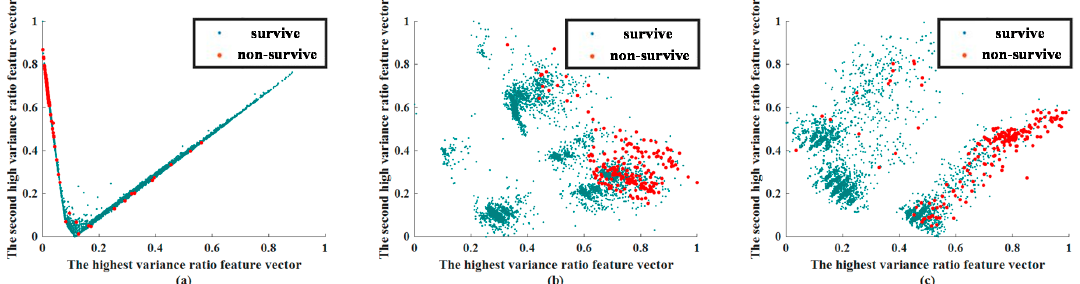
Figure 4. Extracted feature visualization of mortality prediction of testing dataset within 72 h: ( a ) CNN, ( b ) AE, ( c ) PCA. Abbreviation: PCA, principal component analysis; AE, autoencoder; CNN, convolutional neural network.